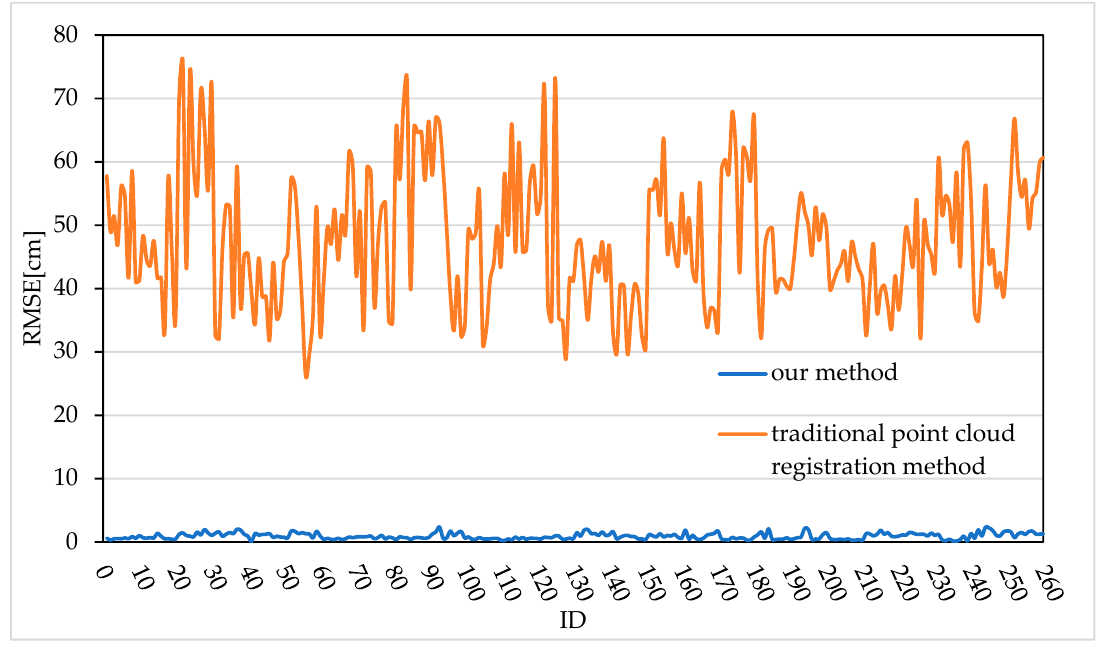
Figure 10. RMSEs of our method and the traditional point cloud registration method.